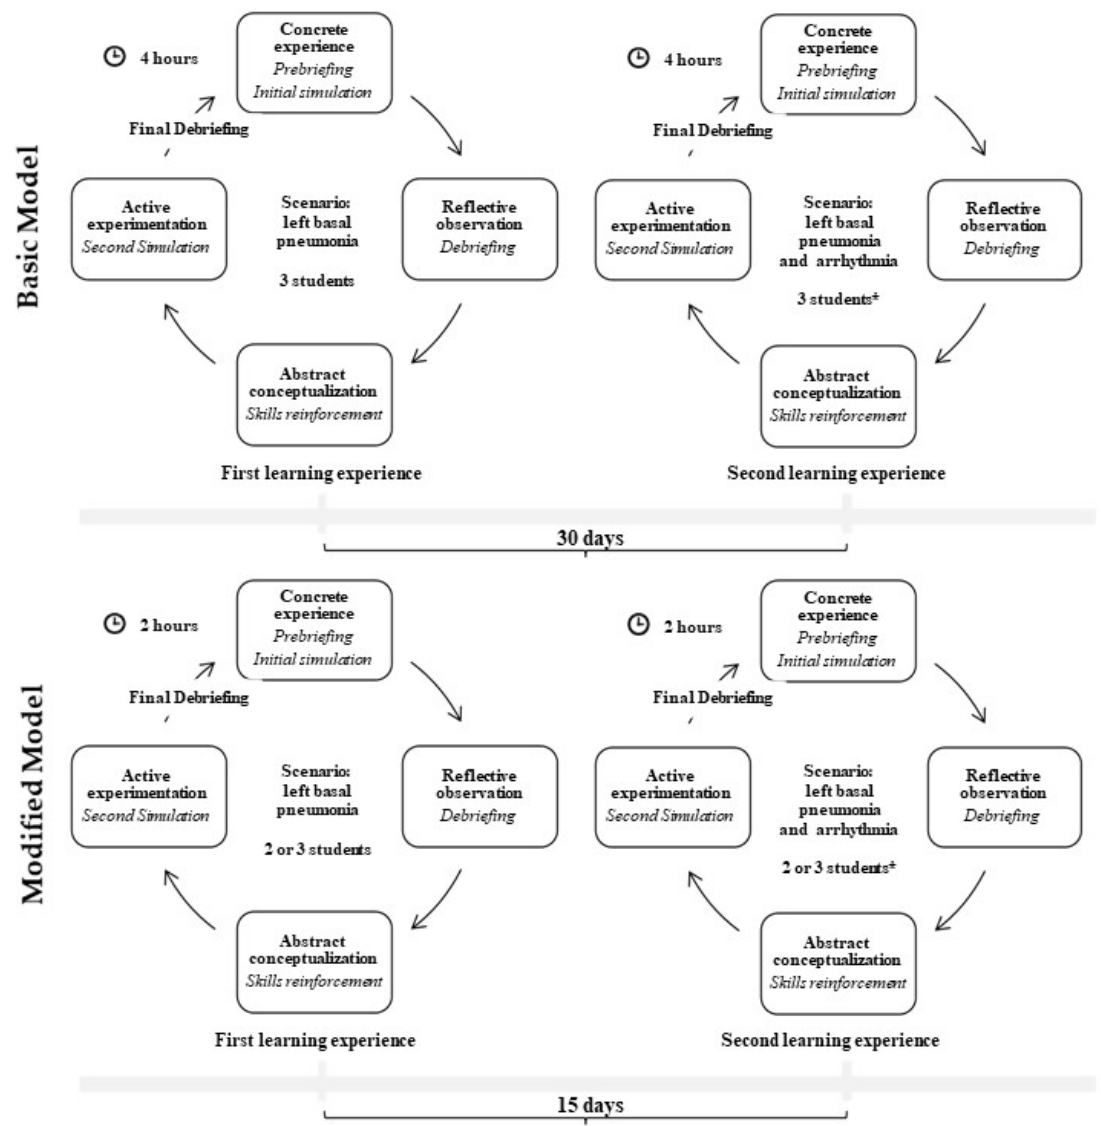
Figure 1. Basic and modified teaching models for simulation activities (* group composition randomly changed).